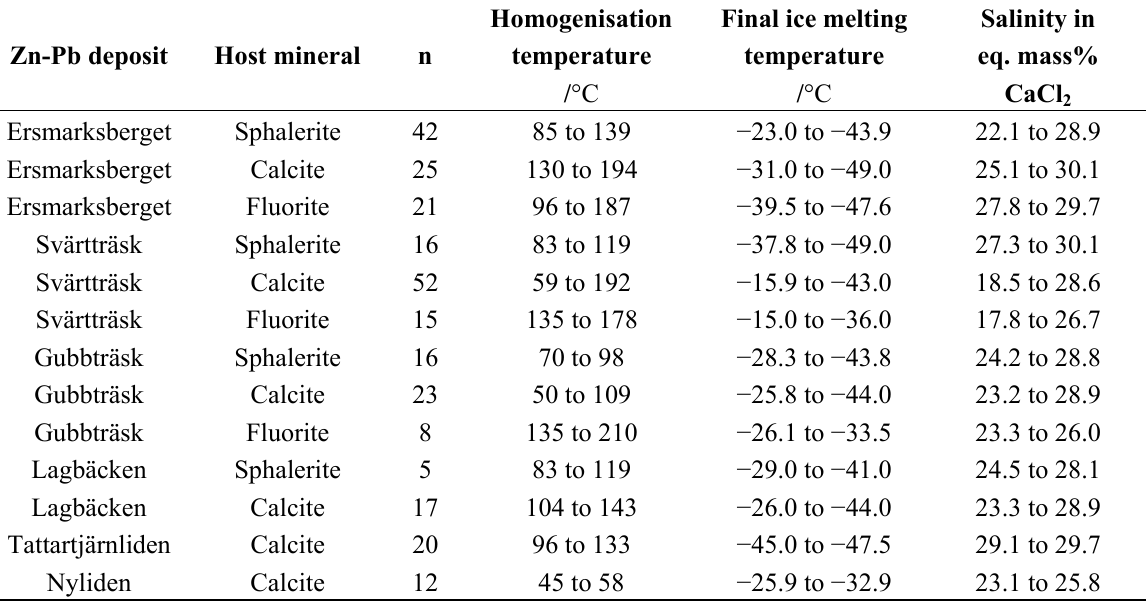
Table 1. Microthermometric data from aqueous fluid